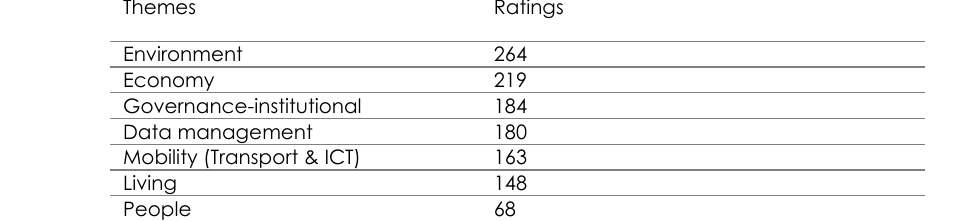
Table 6. Ratings of 7 Key Themes for related KPIs of Smart City in Urban Literature